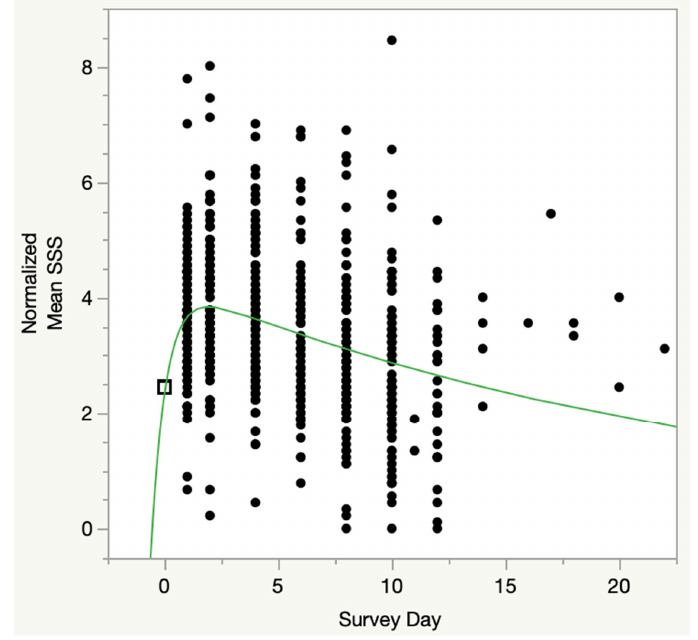
Figure 8. Four Parameter Pharmacokinetic Model of PEM Response to 2 ‐ day CPET. Four ‐ parameter pharmacokinetic model of normalized mean SSS scores. Scores were adjusted for pre ‐ test symp ‐ toms, such that all pre ‐ test values were 2.45 (open box at day 0). Black box represents that in this model all subject’s Mean SSS scores were normalized (set to 2.45 at time 0, or pre ‐ CPET1, for all subjects); Black dots are all other normalized Mean SSS scores for each subject, at subsequent days; Green line is the mathematical solution for the model. Figure 9 shows the one ‐ compartment pharmacokinetics of mean SSS by high, inter ‐ mediate and low pre ‐ CPET1 symptom groups. JMP Pro 16 does not have the ability to run statistics between pharmacokinetic models. These results suggested a higher area under the curve (AUC), i.e., more symptoms, for the low symptom group (Low = 31.0 ± 6.9 vs. High = 15.2 ± 4.4 and Int = 12.9 ± 2.1; mean ± s.e.m.). However, the “elimination rates” appeared to be similar for all three groups (Low = 0.073 ± 0.024, High = 0.094 ± 0.042, Int = 0.149 ± 0.050; mean ± s.e.m.), as were the times to peak response (Low = 2.11 ± 0.53 d, High = 1.35 ± 1.13 d, Int = 2.20 ± 0.53 d; mean ± s.e.m.). The one ‐ compartment pharmacokinetic model reinforced the visual impression that the peak response in symptoms may be blunted in the high symptom group (Low = 1.94 ± 0.30, Int = 1.39 ± 0.52, High = 1.26 ± 0.23; mean ± s.e.m.).